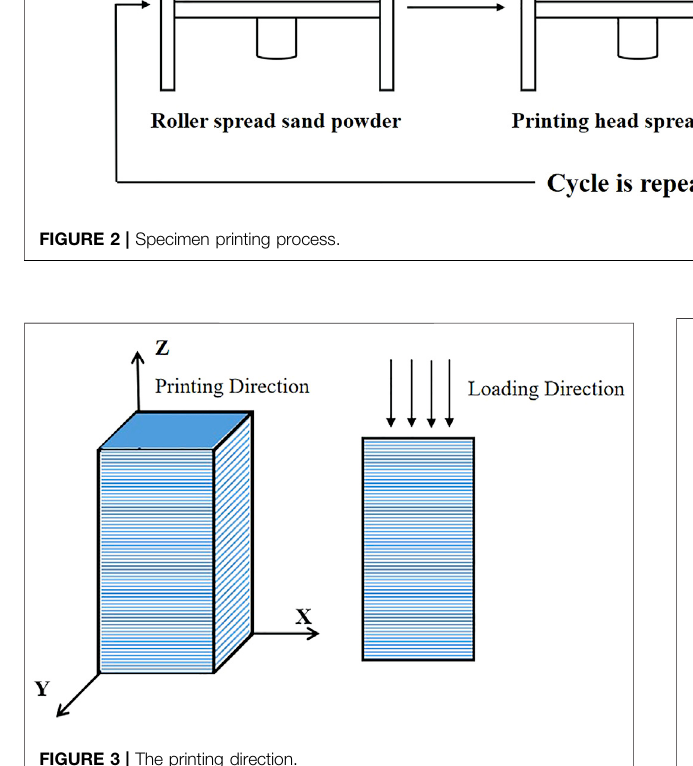
FIGURE 3 | The printing direction.